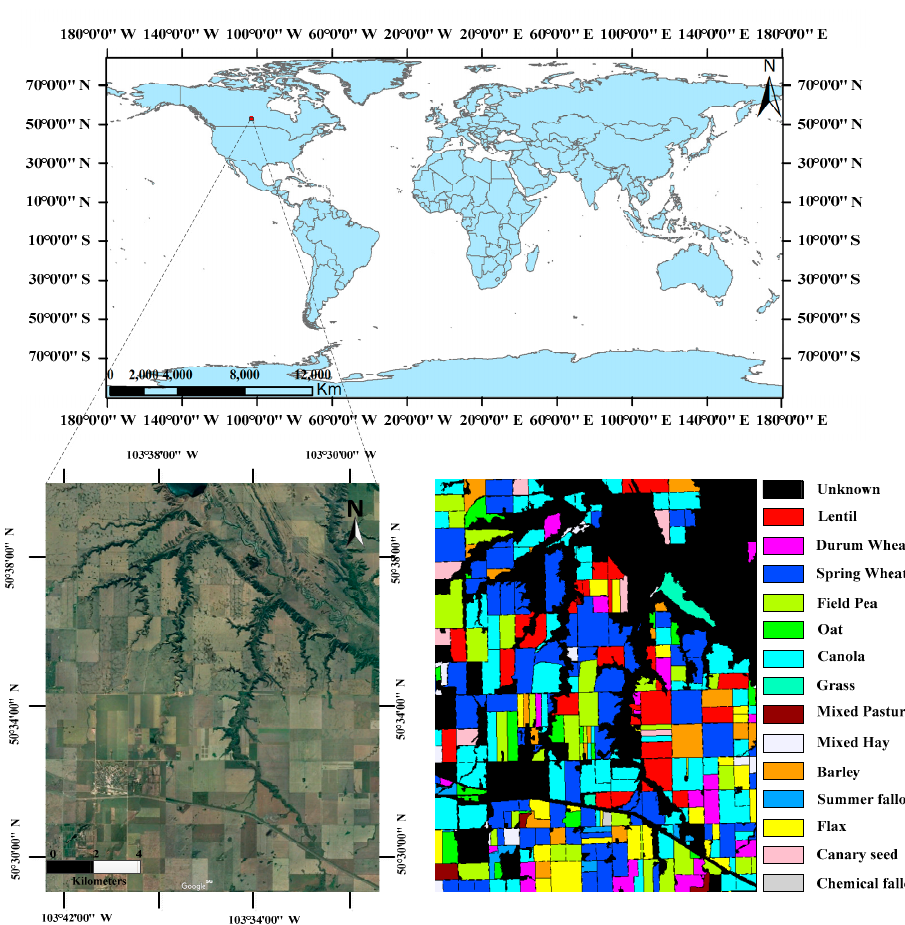
Figure 4. Location maps and Ground truth map of the experimental site.